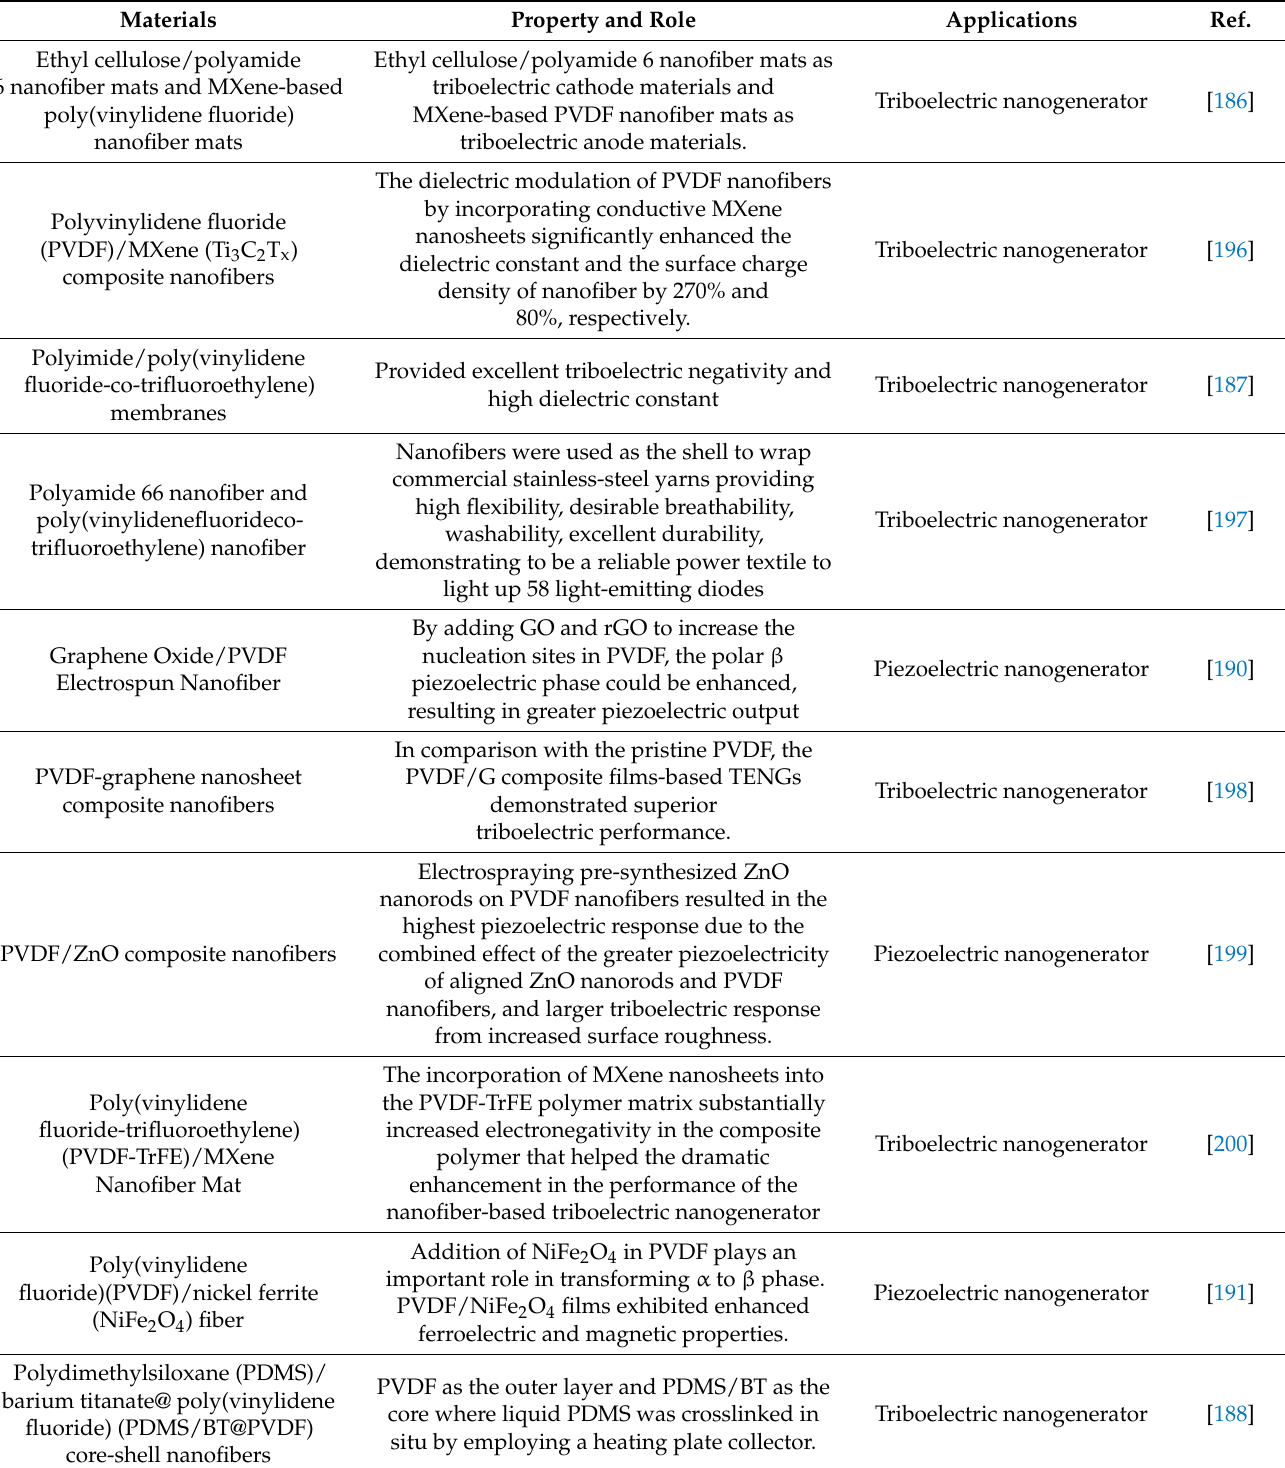
Table 6. Roles of nanofiber materials in various nanogenerator applications. Materials Property and